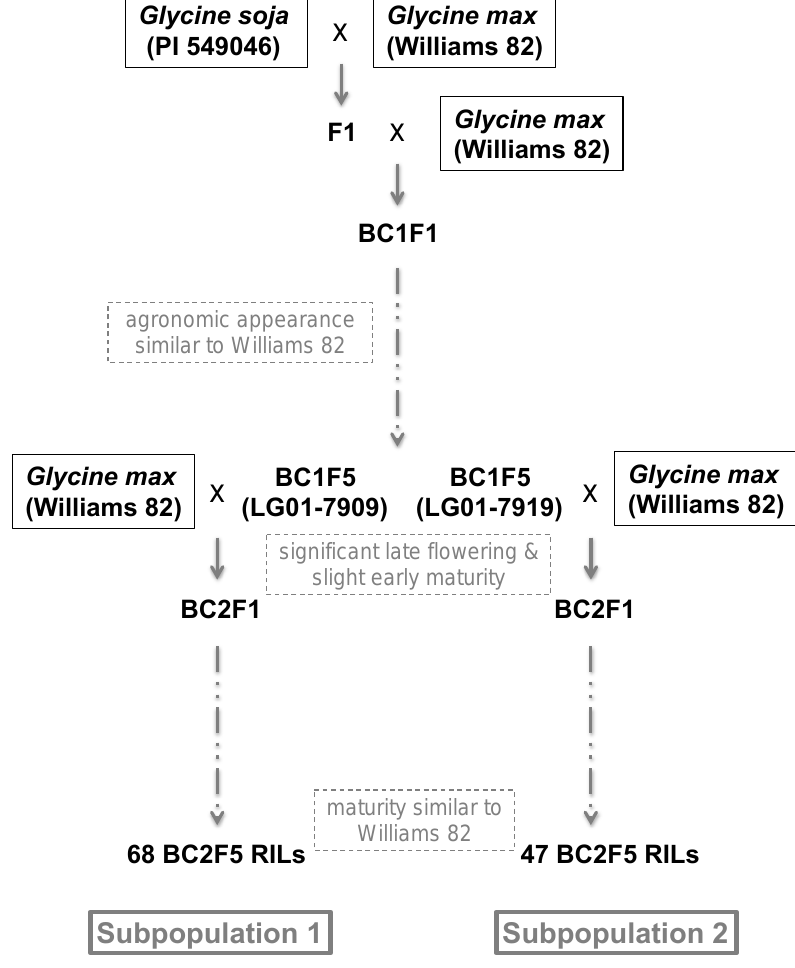
Figure 1. The scheme for mapping population development and selection